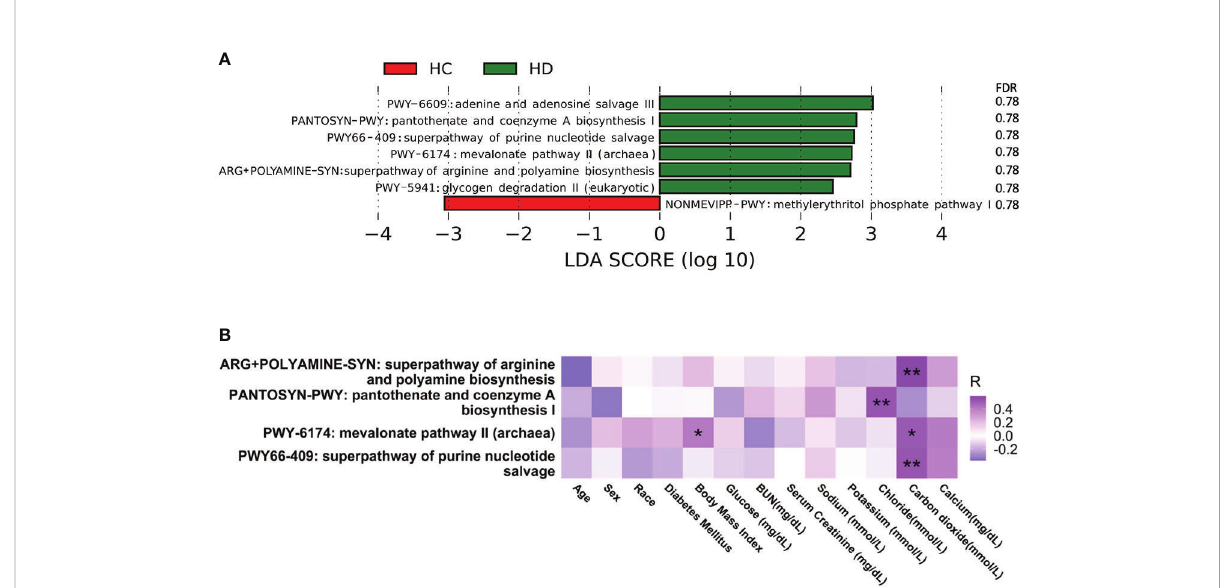
FIGURE 2 Alterations in microbial pathways. (A) Signi fi cantly altered microbial pathways between HD patients and control subjects. (B) Correlation between microbial pathways and clinical parameters. * p -value < 0.05; ** p -value < 0.01. BUN, blood urea